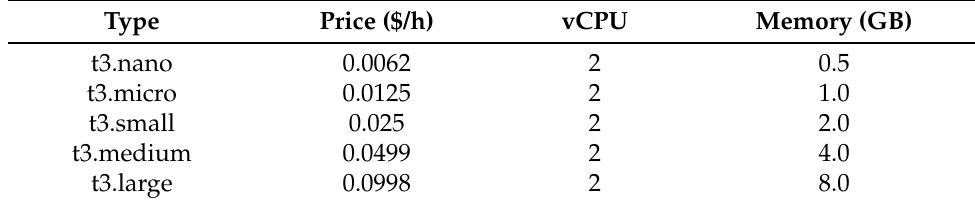
Table 4. Parameters for the five types of cloud